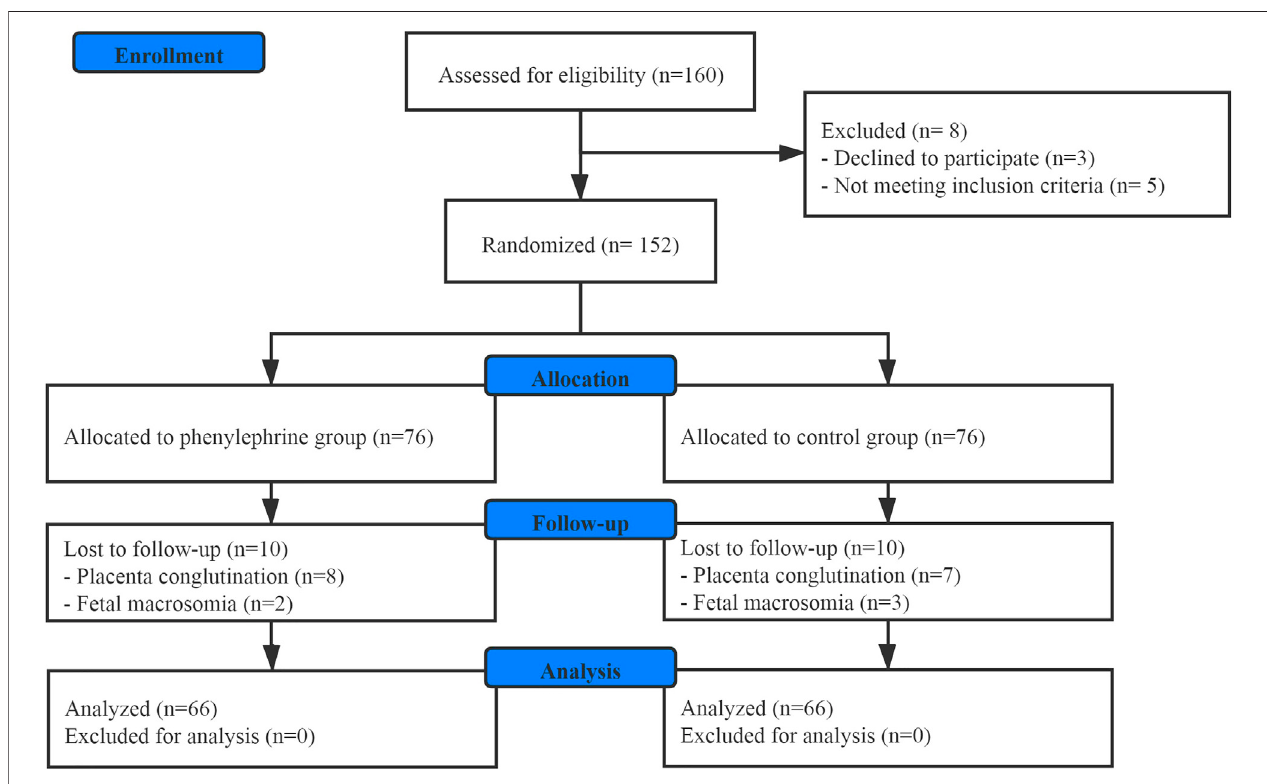
FIGURE 1 | CONSORT